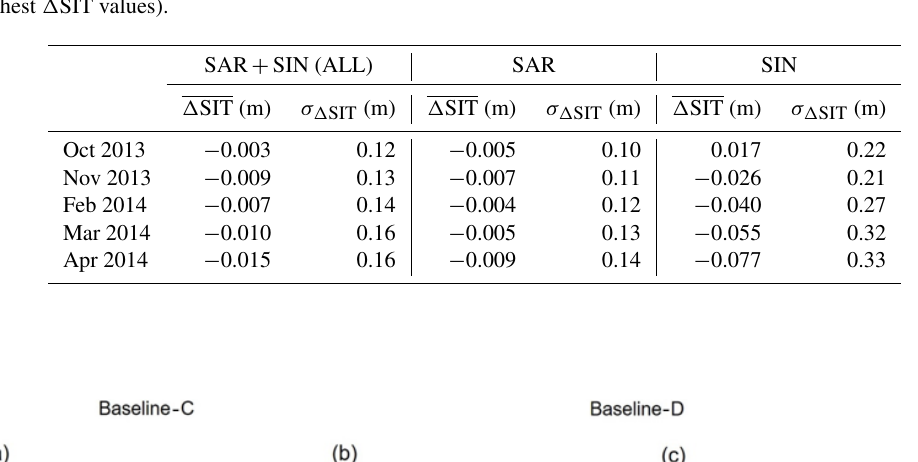
Table 3. Mean thickness difference ( (cid:49) SIT) and standard deviation ( σ (cid:49) SIT ) for all monthly gridded fields during the winter months (October– April) of the Baseline-D TDS. The statistics are broken down into (1) all grid cells with data coverage for both baselines (2) SAR data and (3) SIN data (highest (cid:49) SIT values).